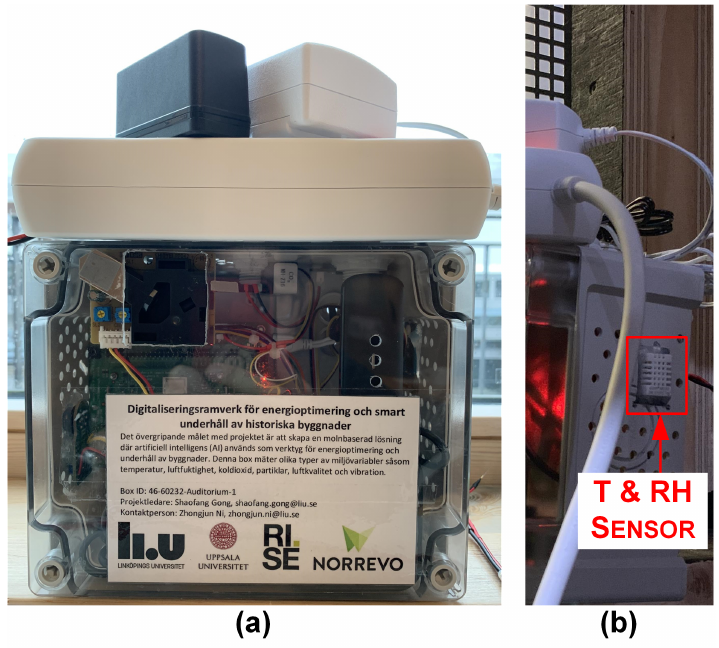
Figure 4. The assembled sensor box. ( a ) Front view and ( b ) right side